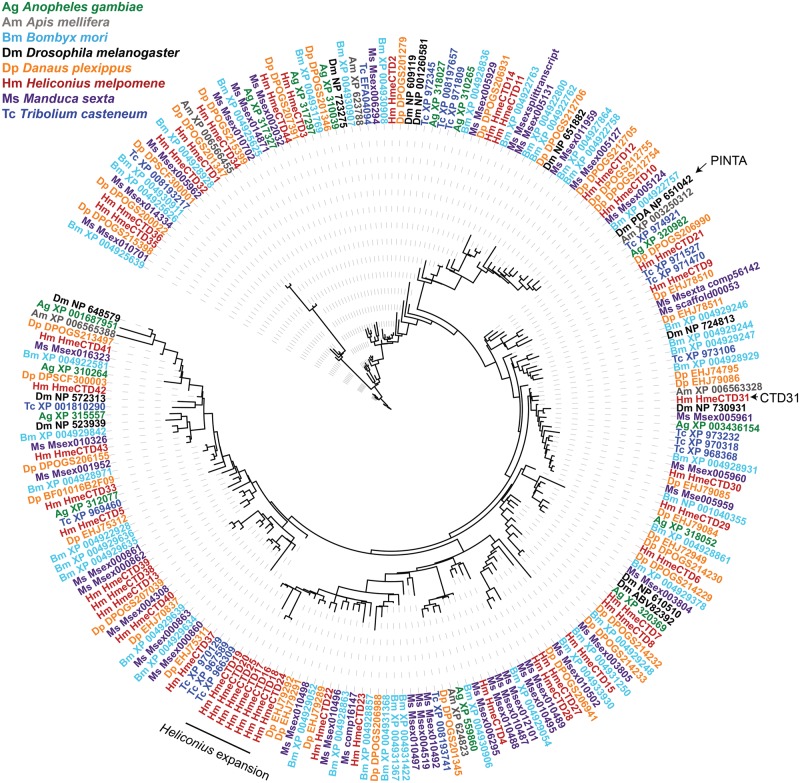

—Bayesian phylogeny of insect CRAL-TRIO domain proteins. Phylogeny includes sequences from Anopheles gambiae (green), Apis mellifera (gray), Bombyx mori (light blue), Drosophila melanogaster (black), Danaus plexippus (orange), Heliconius melpomene (red), Manduca sexta (purple), and Tribolium casteneum (dark blue). The Bayesian tree was found using MrBayes with a BLOSUM62 model of amino acid substitution. The Heliconius expansion as well as Drosophila pinta and Heliconius Hme CTD31 are indicated on the phylogeny with black lines and arrows.